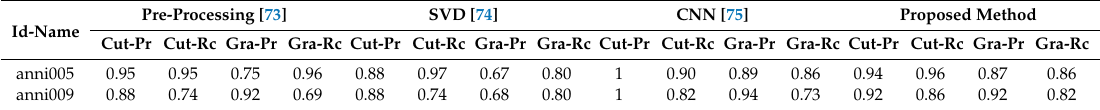
Table 15. The comparison results of shot detection methods.